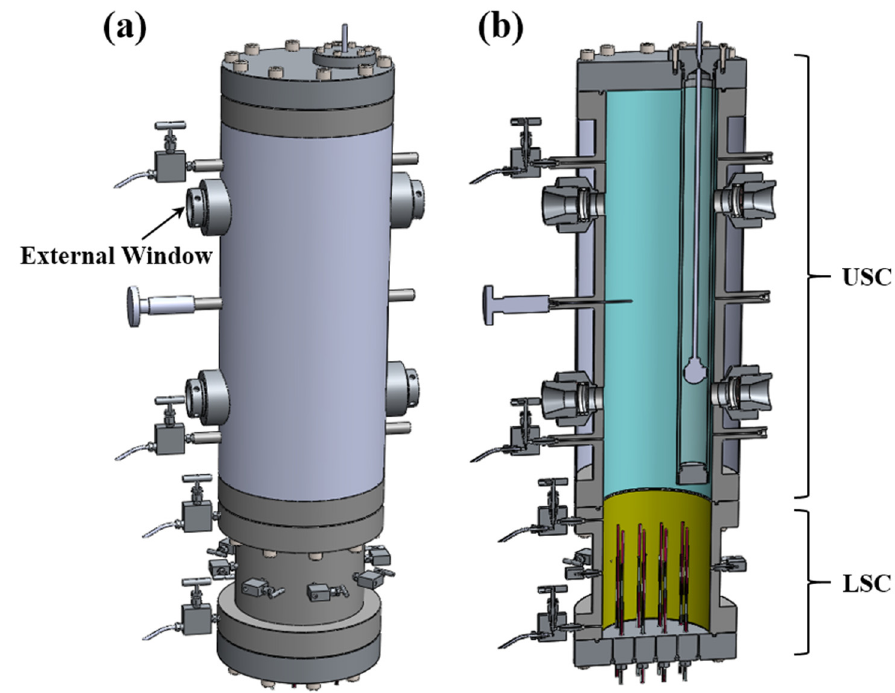
Figure 2. ( a ) Front and ( b ) section views of the DSSWS.